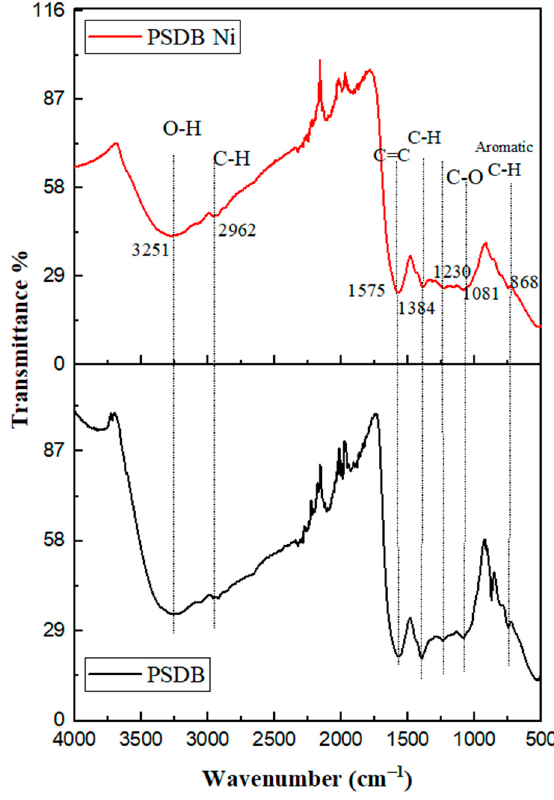
Figure 13. Analysis of infrared spectral bands of PSDB before and after Ni 2+ removal.